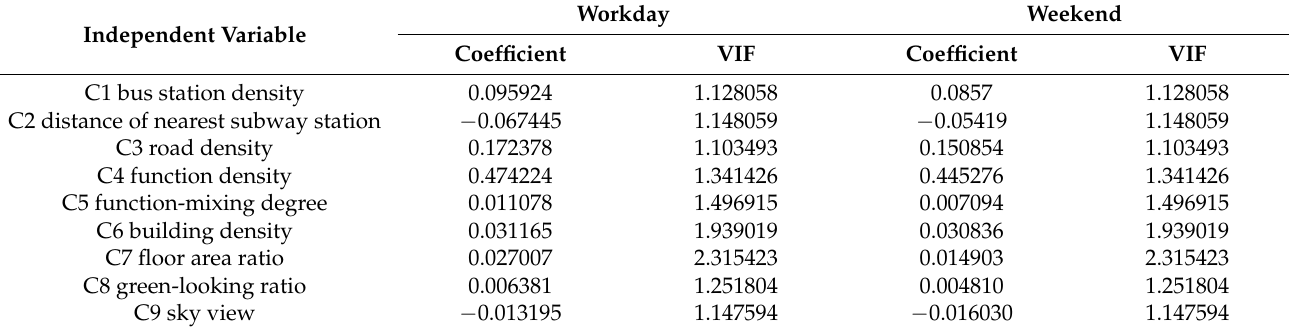
Table 6. Comparison of regression